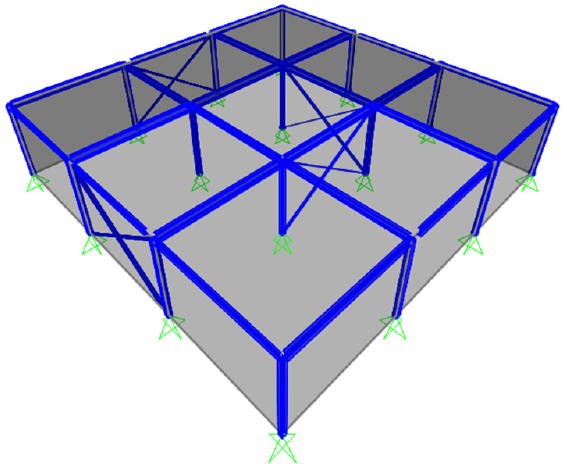
Figure 16. Mono-storey building model with SAP2000 for case studies 3 and 4. Table 9. Results of case study 3 (G: group; S: step).